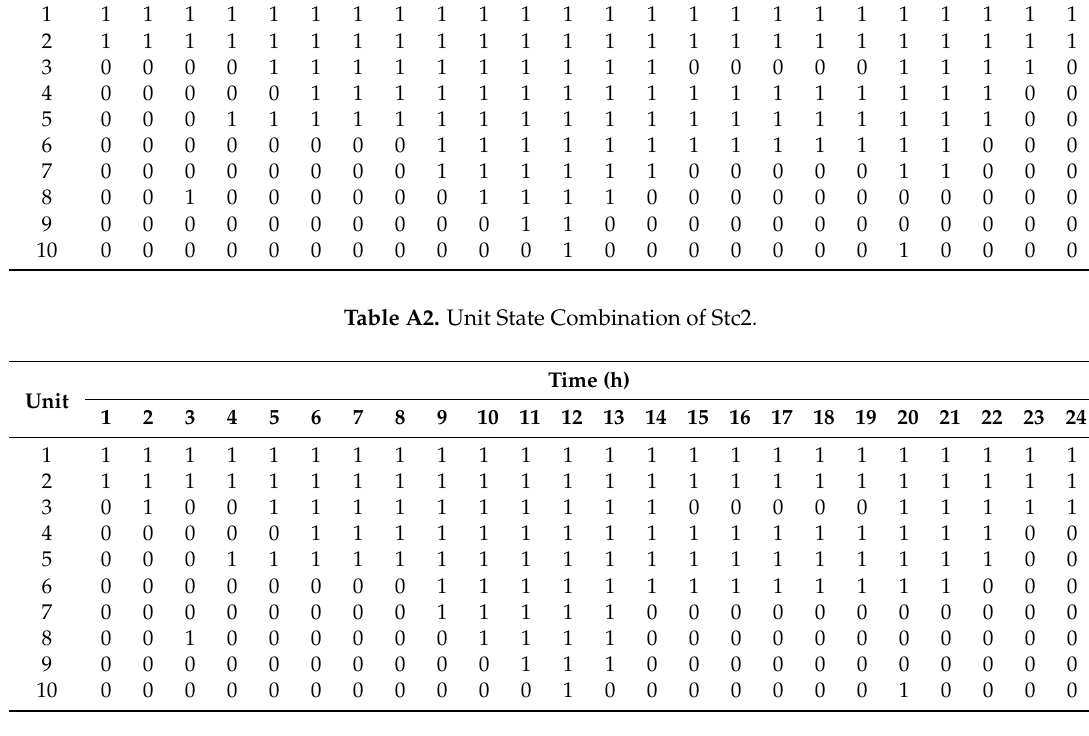
Table A3. Unit State Combination of